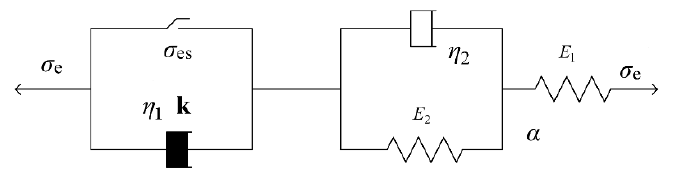
Figure 5. Nonlinear Nishihara model.